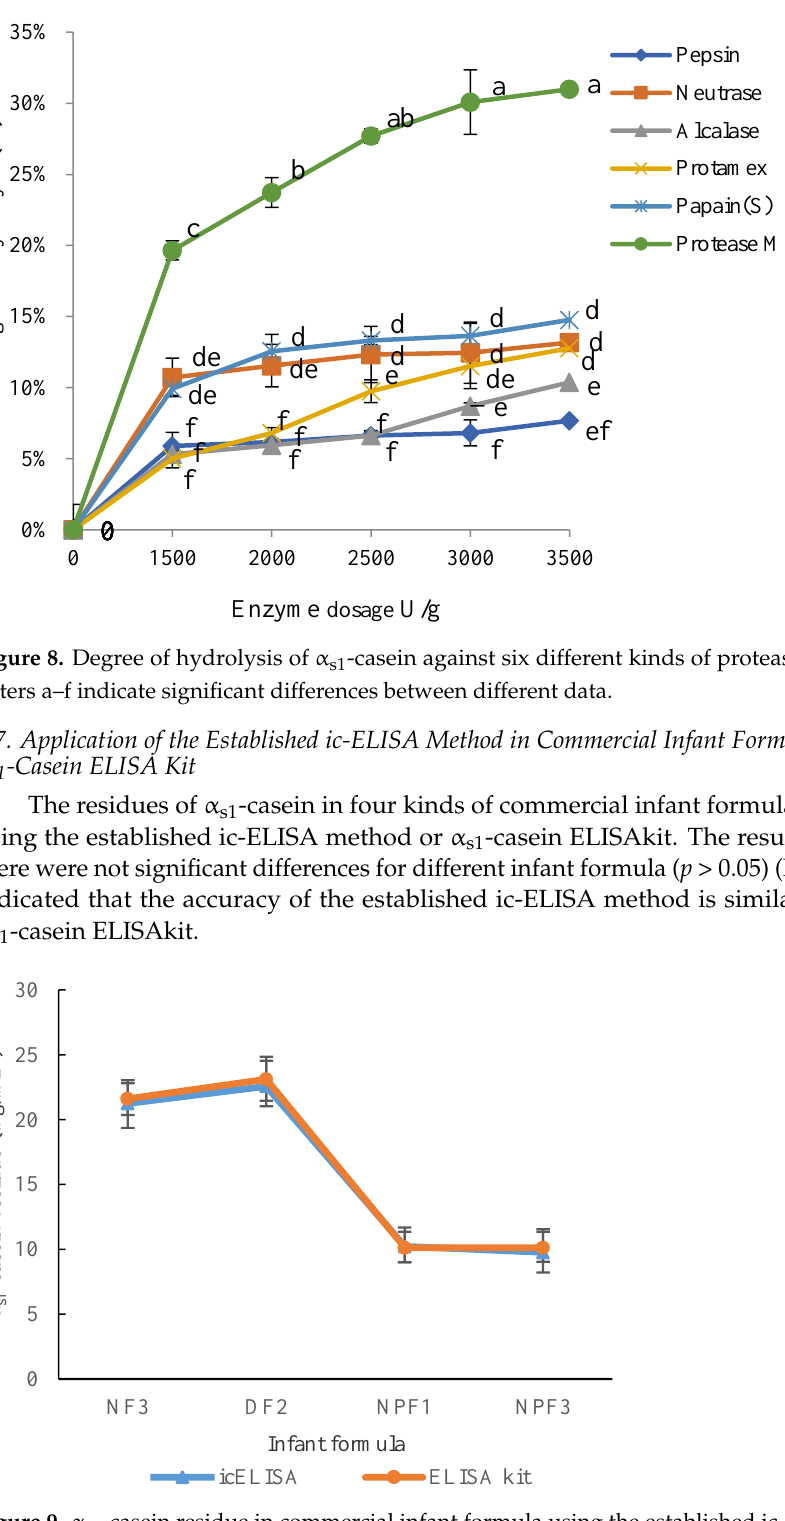
Figure 9. α s1 -casein residue in commercial infant formula using the established ic-ELISA method or α s1 -casein ELISAkit .